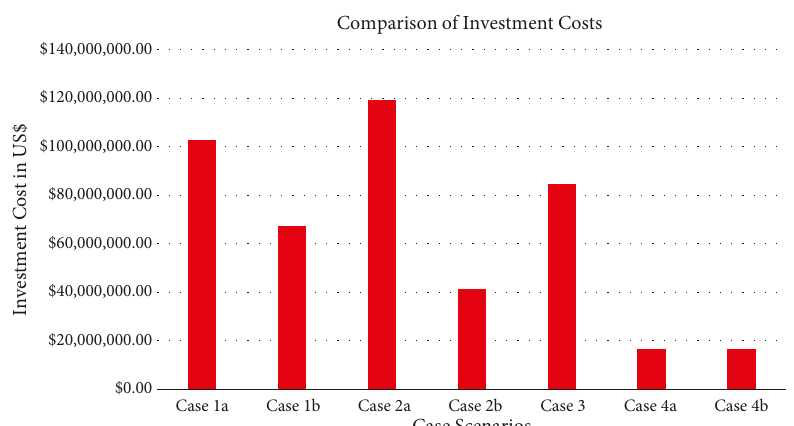
Figure 19: Comparison of investment cost under different